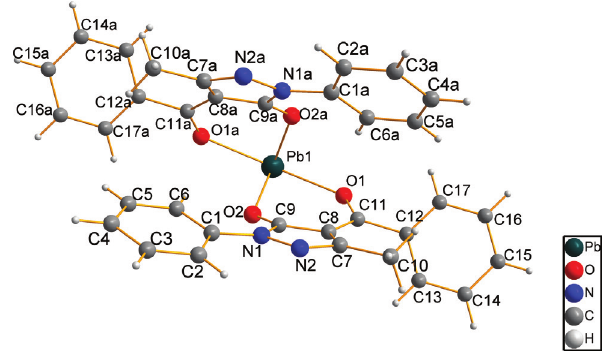
Figure 2 Coordination environments of the Pb atom.